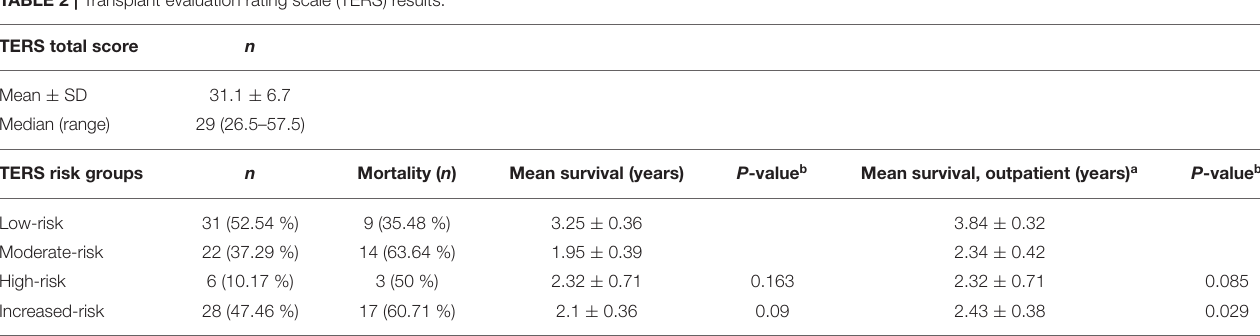
TABLE 2 | Transplant evaluation rating scale (TERS)